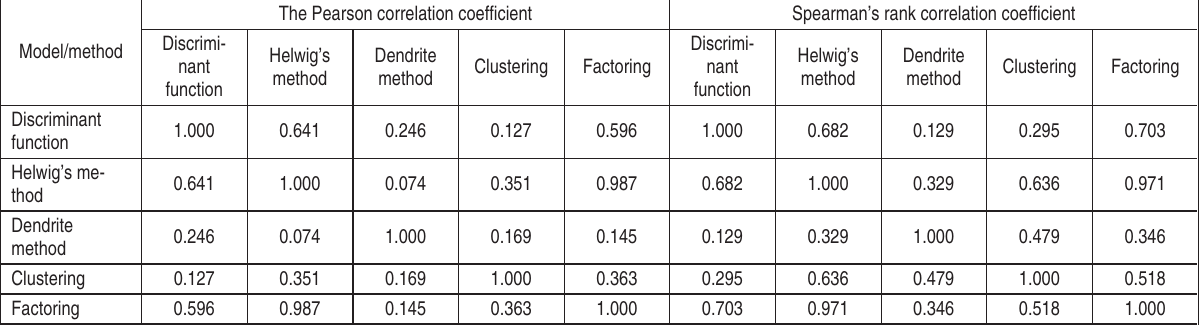
Table 5. The Pearson correlation and Spearman’s rank correlation coefficients Model/method